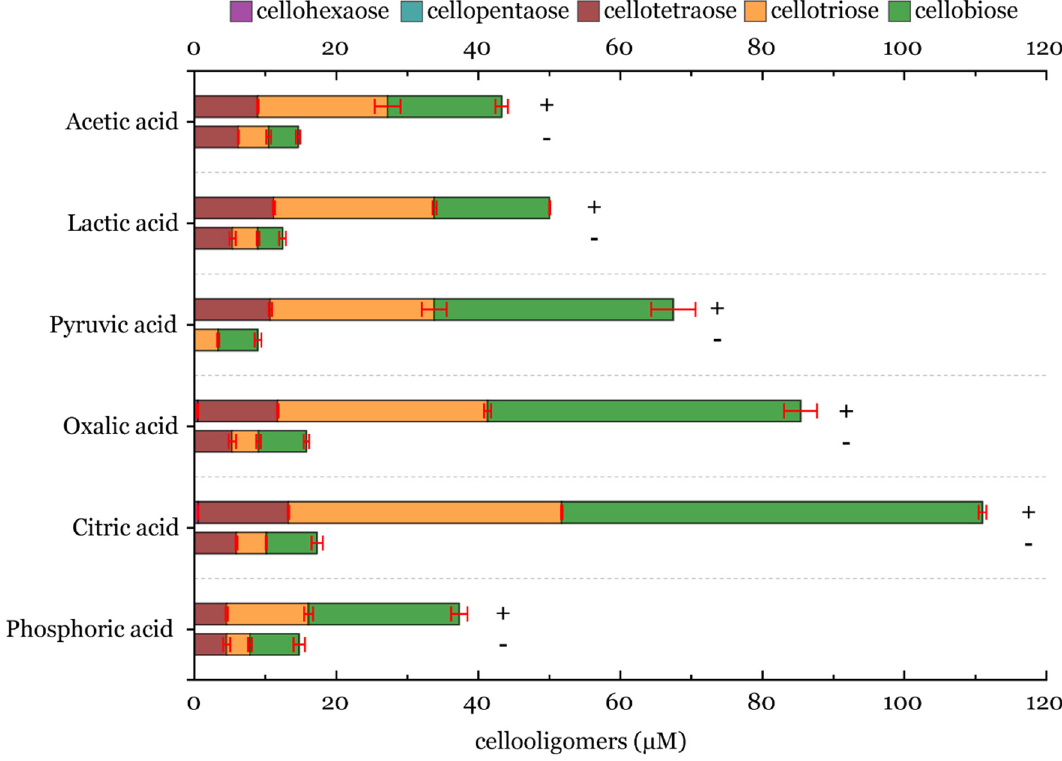
Figure 4. Product release by Nc LPMO9C analyzed with HPLC during batch conversions after 4 h in the presence of inhibitors, 1 mM ascorbic acid as reductant and 100 µM H 2 O 2 as a cosubstrate. H 2 O 2 was added four times every hour. The graph shows staked bars of the cello-oligosaccharide concentrations with (+) and without ( − ) reductant.